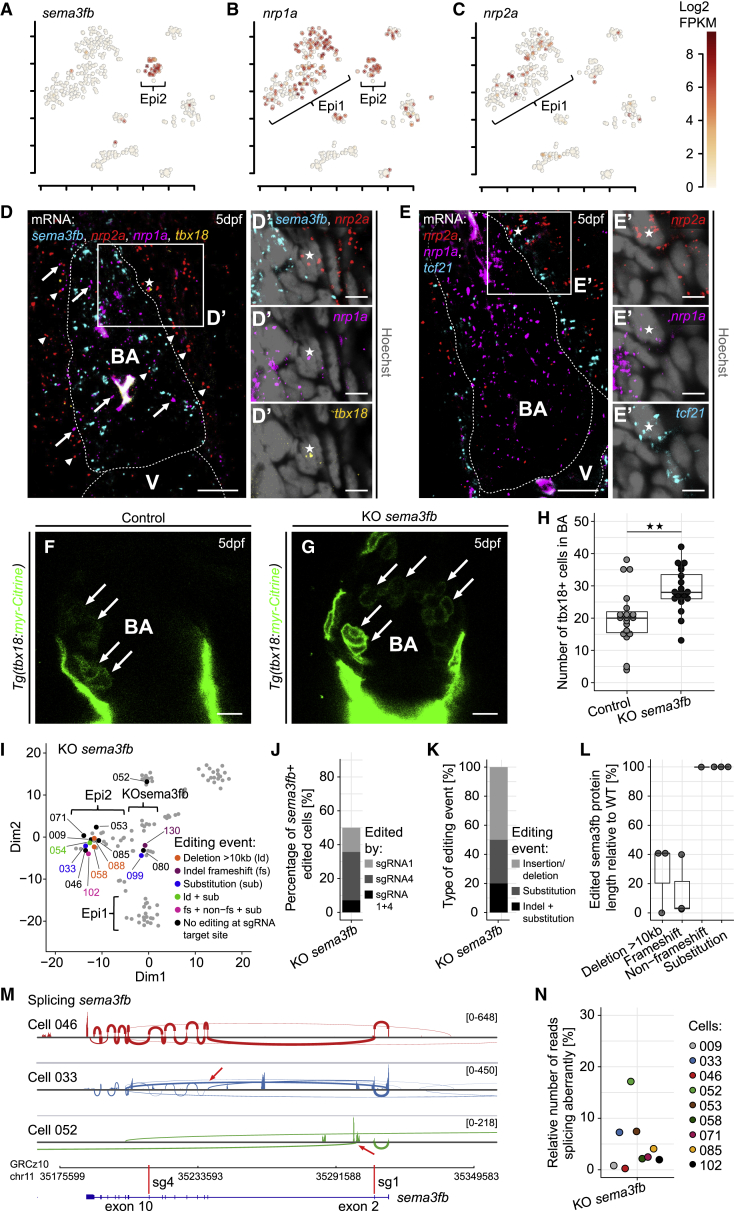
Semaphorin 3fb Is a Marker of Epi2 and Controls the Number of tbx18+ Cells in the Bulbus Arteriosus(A–C) Expression of sema3fb (A), nrp1a (B), and nrp2a (C). Color key indicates range of log2 transformed FPKM values.(D) mRNA staining of sema3fb (cyan), nrp2a (red, arrowheads), nrp1a (magenta, arrows), and tbx18 (orange) at 5 dpf. (D′) Close proximity of nrp2a, nrp1a, and tbx18 to a nucleus (asterisk) at the BA boundary.(E) mRNA staining of nrp2a (red), nrp1a (magenta), and tcf21 (cyan) at 5 dpf. (E′) A nucleus (asterisk) in close proximity to nrp2a, nrp1a, and tcf21.(F) The BA in a 5 dpf control larva.(G) Increased numbers of tbx18:myr-Citrine+ cells (arrows) in the BA of a KO sema3fb larva.(H) Absolute quantification of tbx18:myr-Citrine+ cell numbers in the BA at 5 dpf.(I–N) Analysis of gene editing in single sema3fb-mutated epicardial cells. (I) t-SNE plot showing cell clusters and editing events. Numbers indicate cell identities, and colors depict editing events. Ld, large deletion; fs, frameshift; and sub, substitution. (J) Relative number of Cas9-edited sema3fb+ cells. Colors indicate the sema3fb sgRNA target site edited. (K) Frequency of editing event types. (L) Inferred edited sema3fb protein lengths, relative to WT. (M) Sashimi plots showing splicing of sema3fb. Arrows highlight reads splicing abnormally. Red bars indicate sgRNA target sites. (N) Relative number of sema3fb splicing reads that spliced abnormally.Scale bars: 10 μm in (D)–(G) and 5 μm in (D′) and (E′). Color channels were adjusted separately for brightness and contrast. (D)–(G) are single optical sections. Data in (H) and (L) are represented as median, first, and third quartiles (box). Significance calculated using Welch’s t test. ∗∗p < 0.01. V, ventricle; BA, bulbus arteriosus.See also Figure S6.